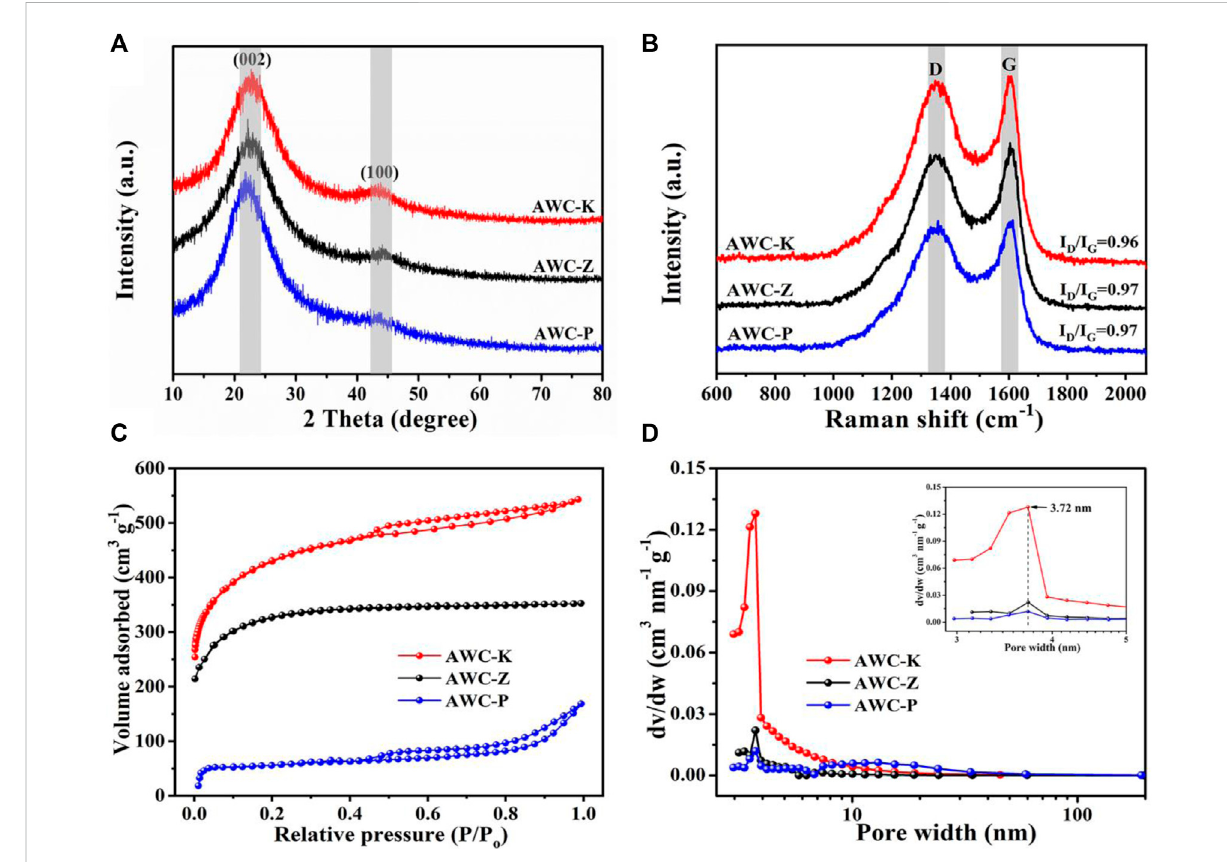
FIGURE 4 (A) XRD patterns of the AWC-K, AWC-Z, AWC-P; (B) Raman spectrum of the AWC-K, AWC-Z, AWC-P; (C) Nitrogen sorption isotherms and (D) pore size distribution curves of the